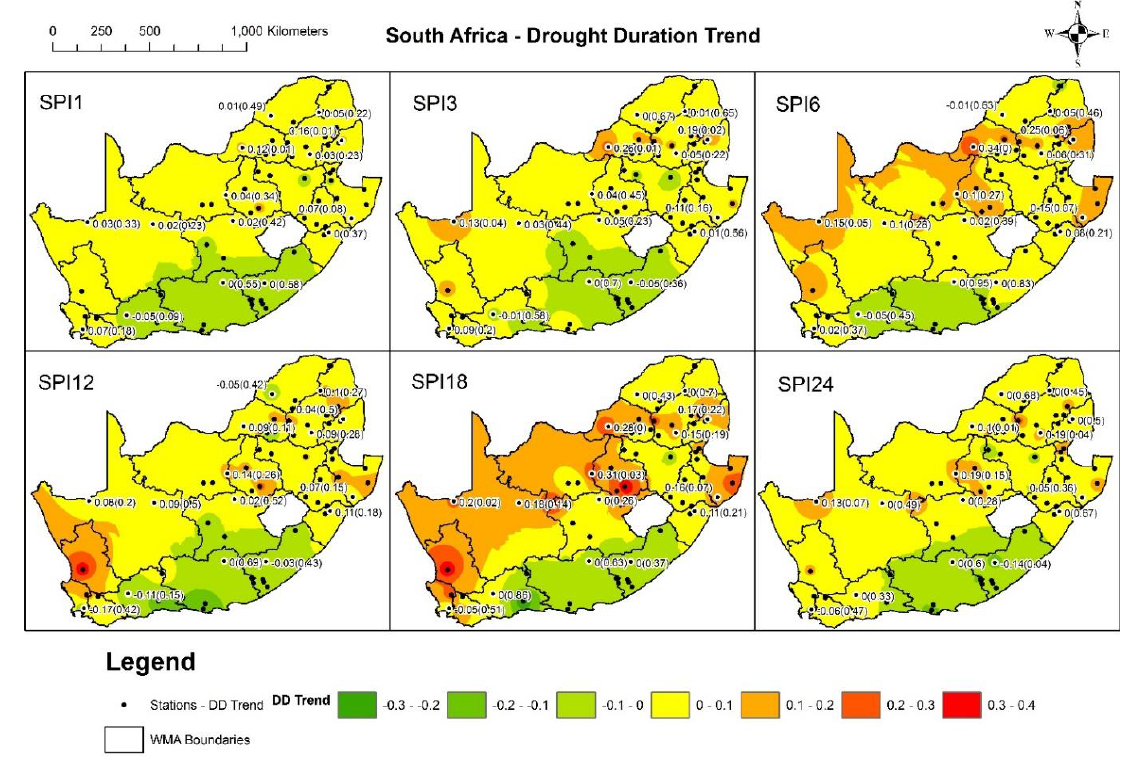
Figure 5. Trends in drought duration derived from SPI-1, SPI-3, SPI-6, SPI-12, SPI-18, and SPI-24 accumulation periods. The significance levels are given in brackets.